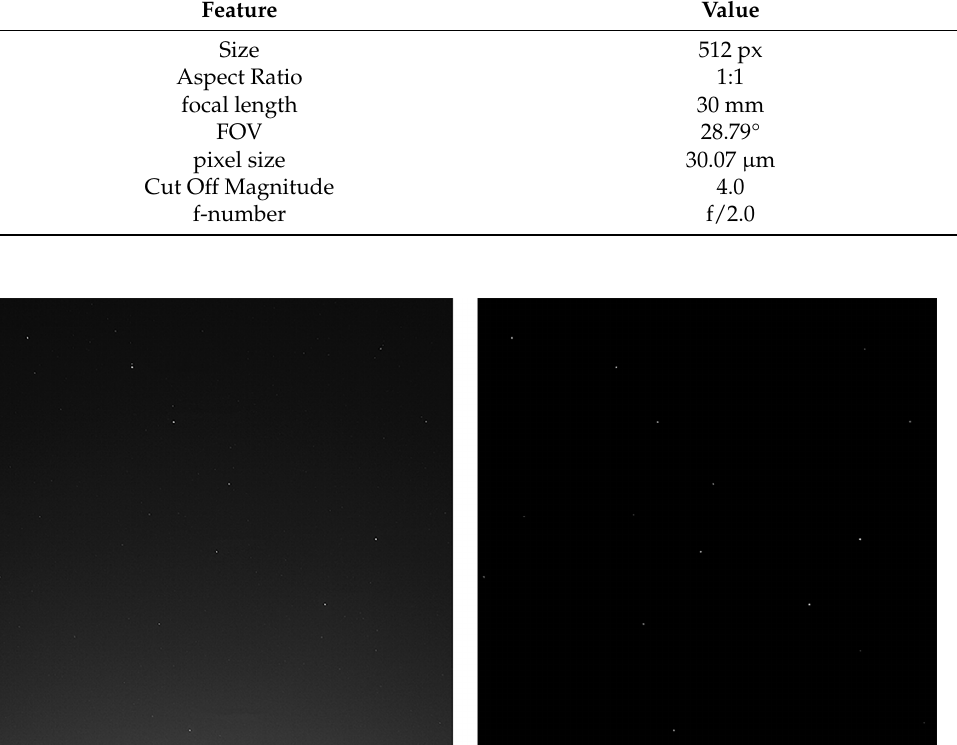
Figure 10. Ursa Major constellation segmentation provided by the BOSS algorithm. Left : real Ursa Major image; right : BOSS output of the Ursa Major real